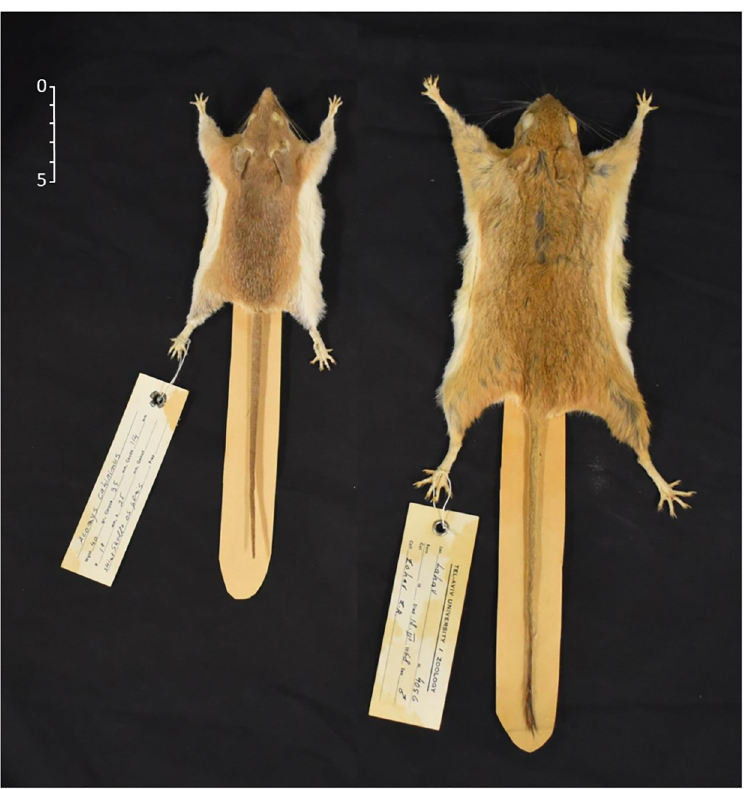
Fig 1. The anatomical difference between common spiny mouse (left) and Tristram’s jird (right). As shown, the hindlegs in the jird are about 1.5-fold longer than its forelegs; while in the spiny mouse foreleg and hindleg length are almost the same [courtesy of Steinhardt Museum of Natural History, at Tel-Aviv